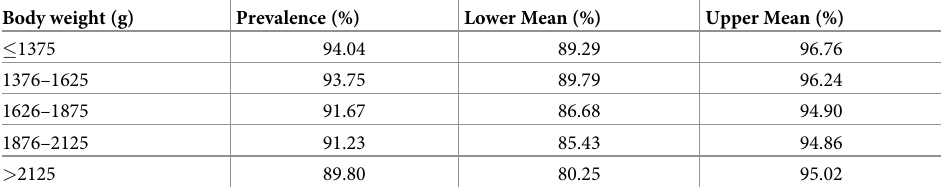
Table 11. The prevalence of keel bone fracture in end of lay hens according to BW at depopulation (250 g inter- vals) (n = 4756). Body weight (g)